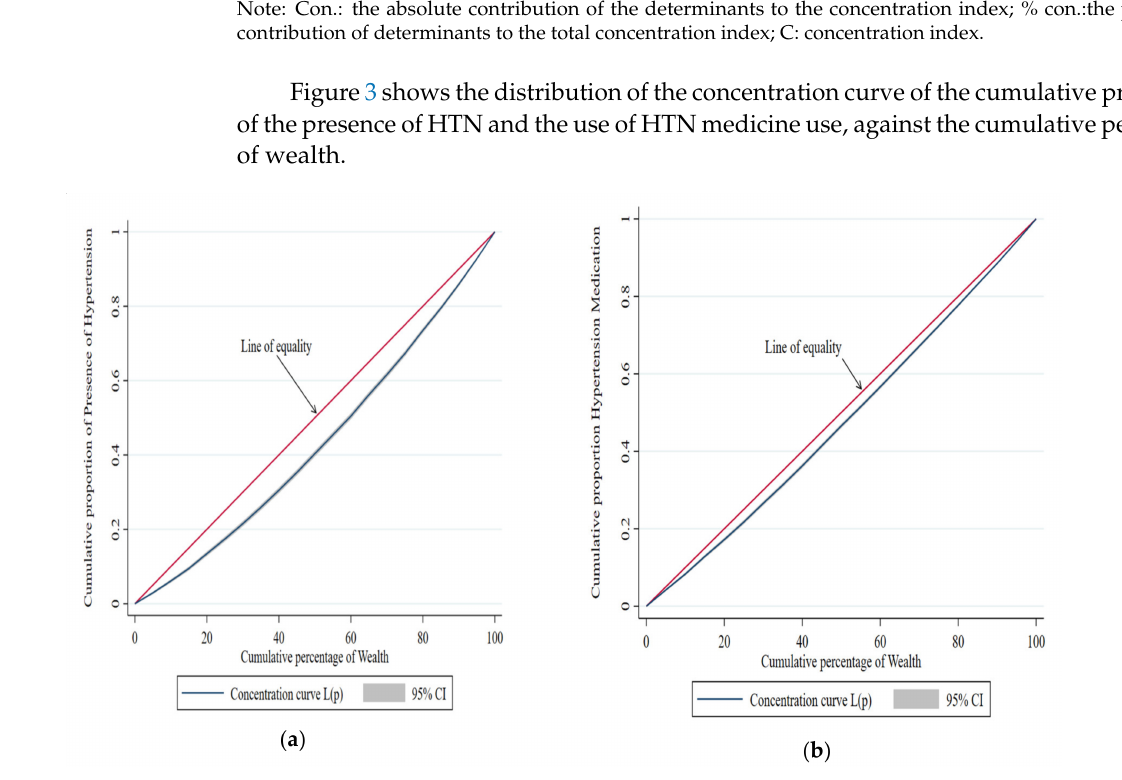
Figure 3. Concentration curve for the cumulative proportion of the presence of hypertension and the use of hypertension medications, against the cumulative percentage of wealth, India (LASI). ( a ) De- scription of the cumulative proportion of presence of hypertension in the first panel; ( b ) description of the use of the cumulative percentage of hypertension medications in the second